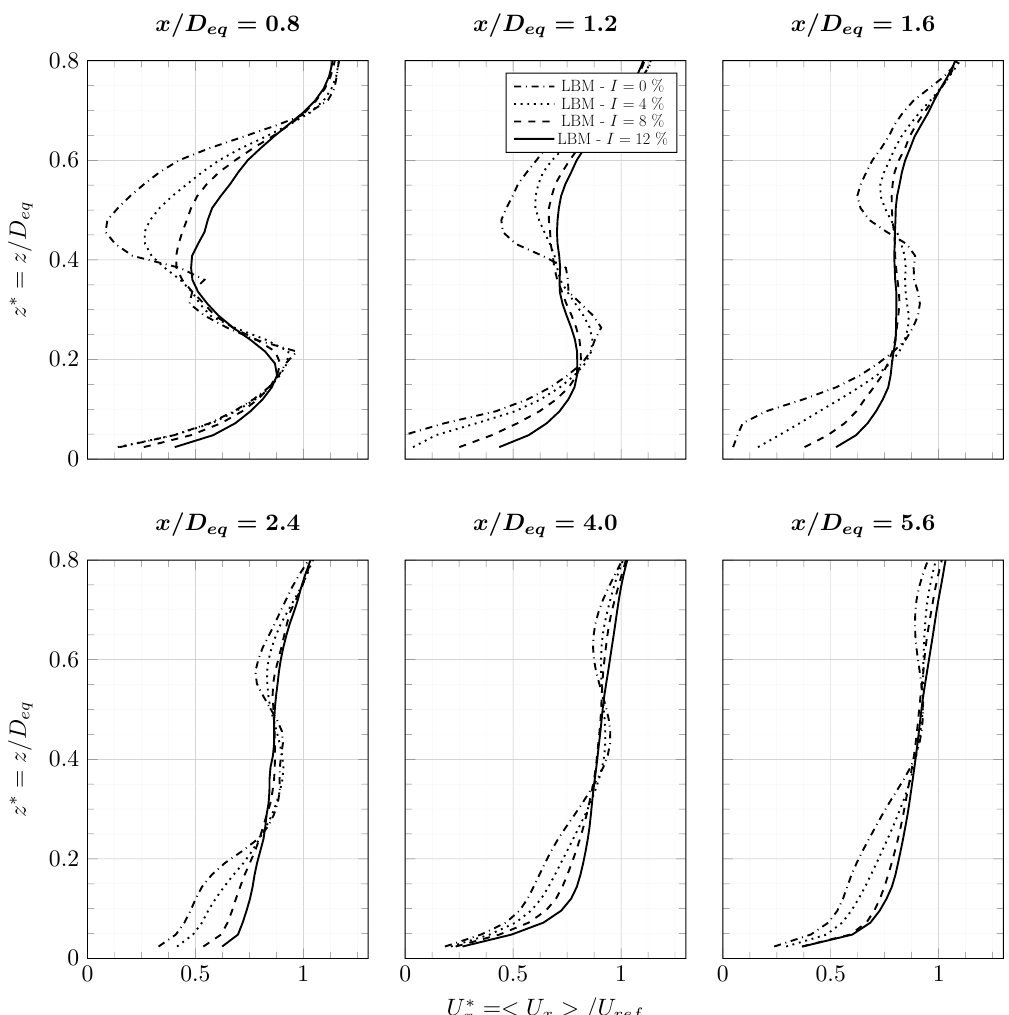
Figure 18. Average axial velocity z profiles in the wake of the tidal turbine at TSR = 1.5. Vertical profiles aligned with rotors center. Since y profiles are symmetrical, only the profiles from the positive y side rotors are shown. ALM-LBM results for the four turbulence rates. Dimensions are scaled by the equivalent diameter D eq = 25.0